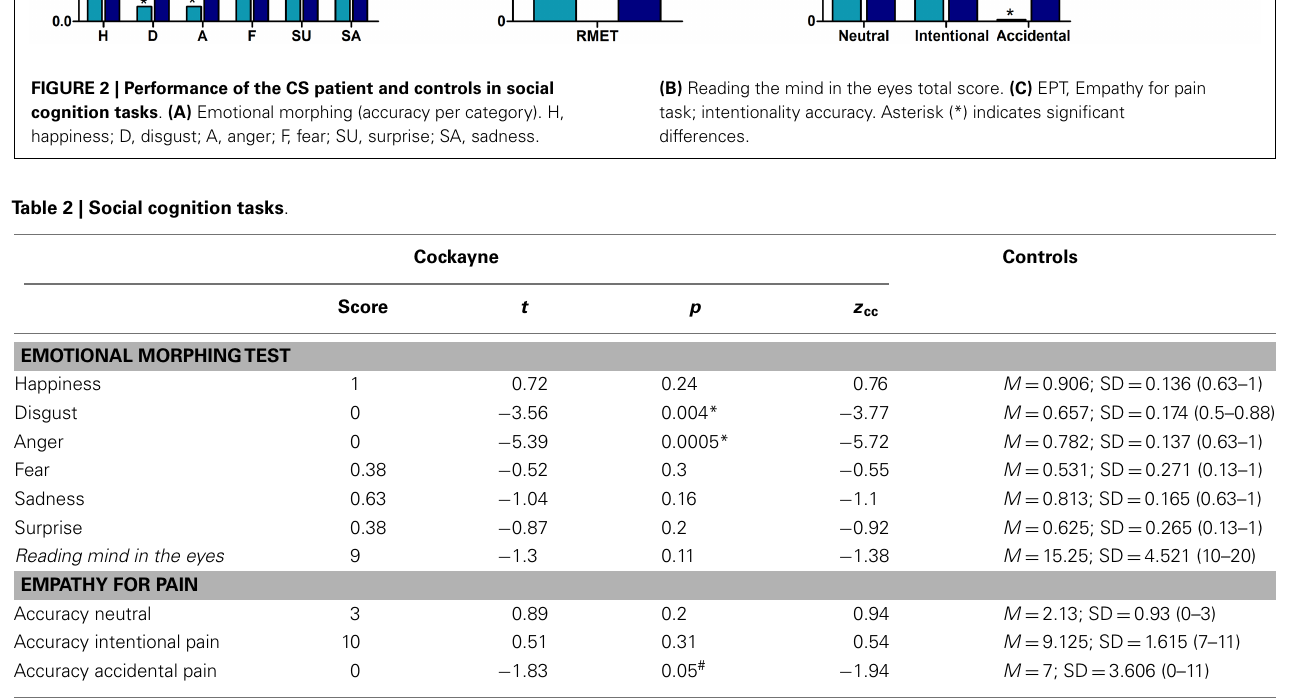
(B) Reading the mind in the eyes total score. (C) EPT, Empathy for pain task; intentionality accuracy. Asterisk (*) indicates significant differences.